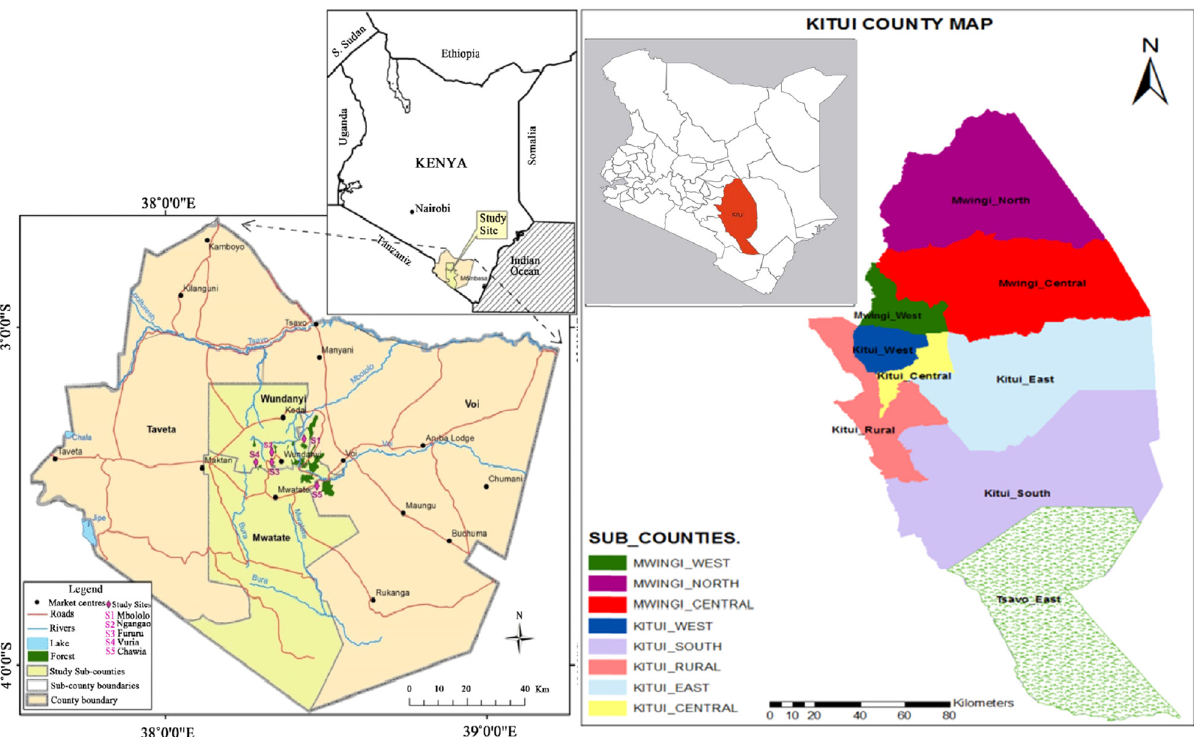
Figure 1: Map of Taita Taveta and Kitui Counties. Source County Government of Kitui ( 12 ) and GoK ( 10 )